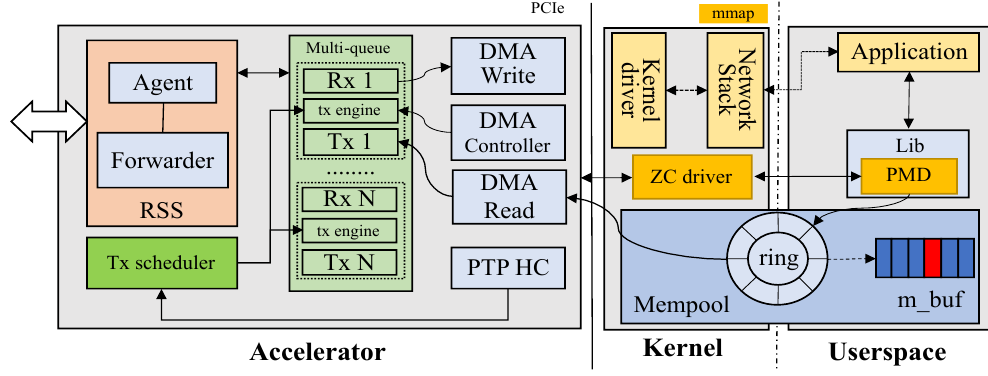
Figure 1. Deterministic multi-queue accelerator